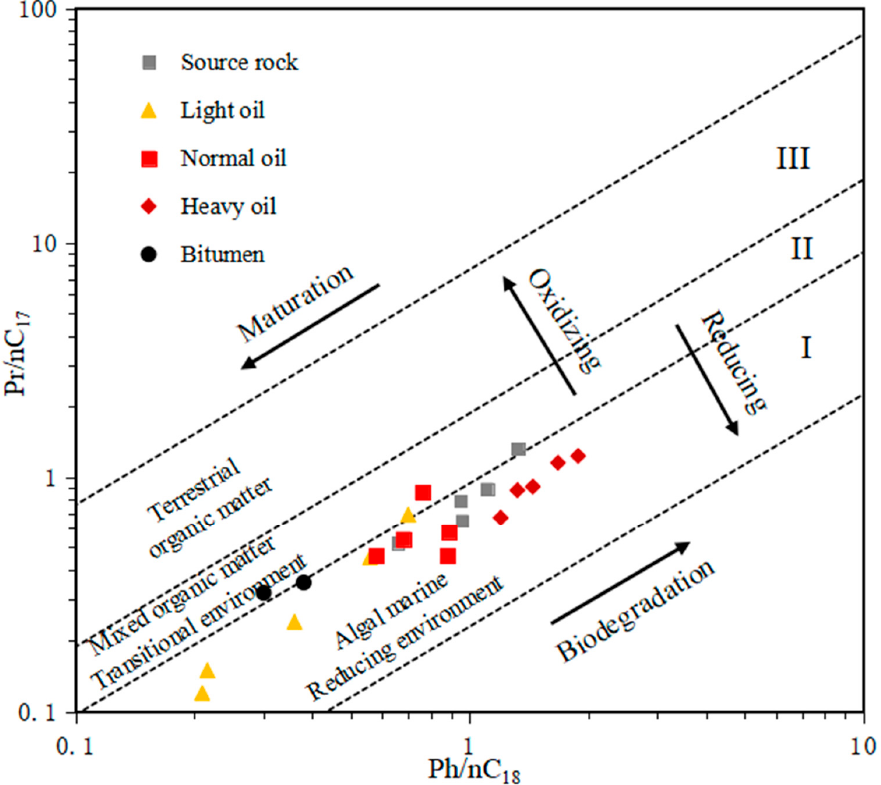
Figure 6. Pr/nC 17 vs. Ph/nC 18 diagram of source rocks and crude oil samples in Wuerhe area, showing most of the samples are distributed in the range of type Ⅰ . ( Ⅰ : Organic matter produced by algae; Ⅱ : Organic matter produced by algae and terrestrial; Ⅲ : Organic matter produced by terrestrial).